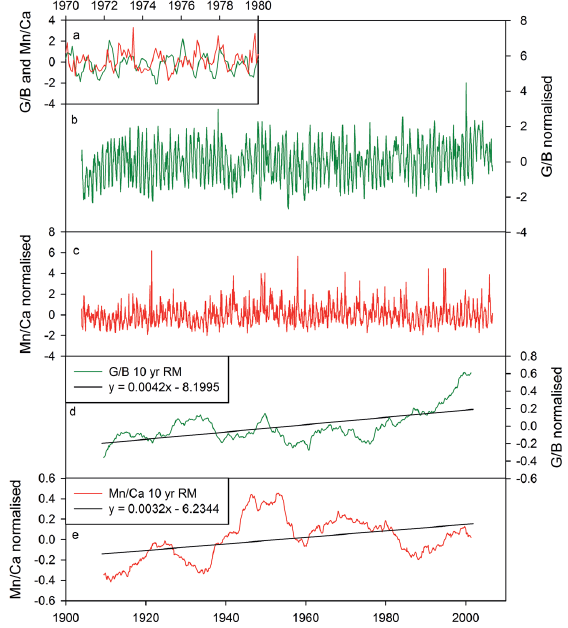
Fig. B1. The seasonal alignment of (a) the MAS1 coral G/B record with Mn/Ca values for the years 1970–1980. The complete MAS1 time series of normalised (b) G/B and (c) Mn/Ca is shown in green and red, respectively. The 11yr running means of (d) G/B and (e) Mn/Ca are shown together with linear trends of monthly data (black line). The regression equations of each line are given in the top left hand corner of each plot. Note that the trend lines have a similar Figure B02 slope.